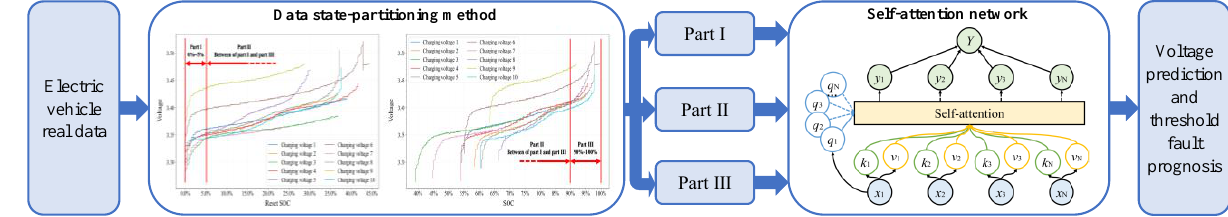
Figure 1. The proposed model structure.